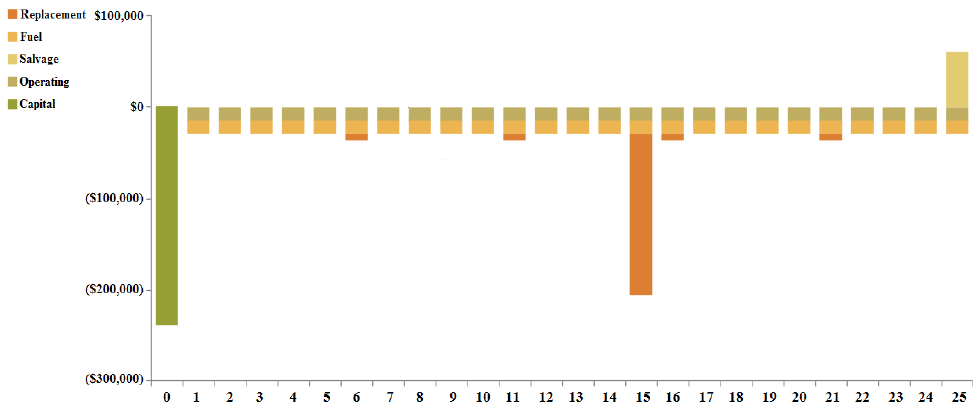
Figure 18. Total cash-flow study for case II (Ba/Bi/S).